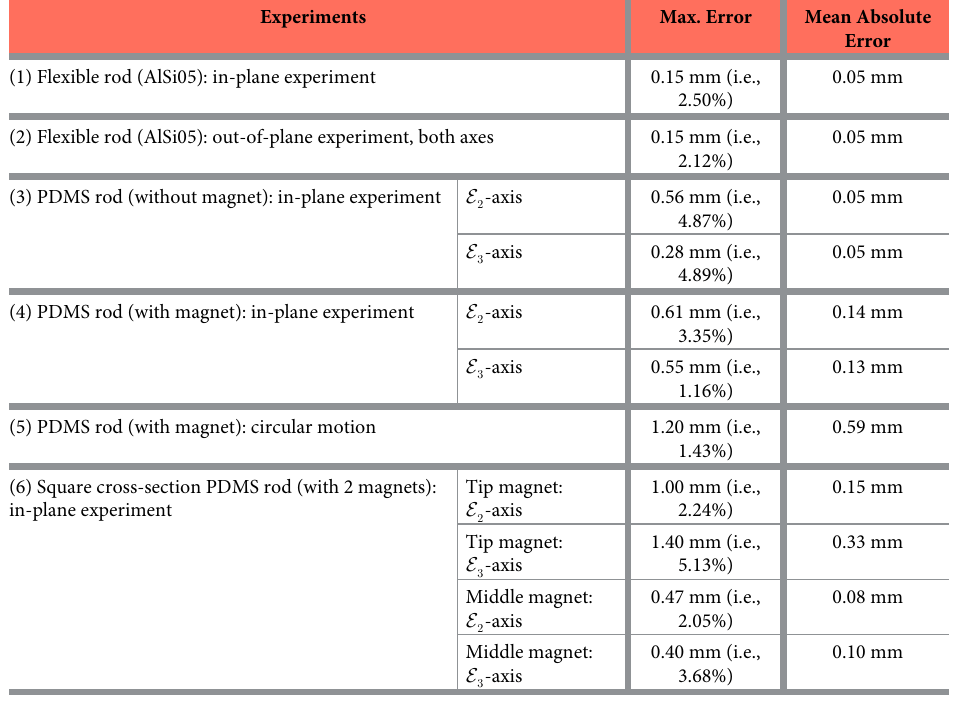
Table 8. Maximum and mean absolute error in the experiments using flexible metal rods (AlSi05) and Polydi- methylsiloxane (PDMS) rods. Experiments Max. Error Mean Absolute